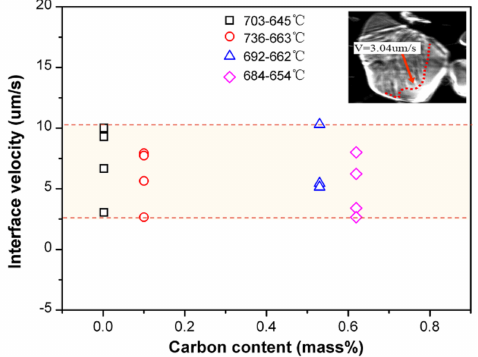
Figure 9. Phase transition interface velocity for steels at a low temperature range with a cooling rate of 1 ◦